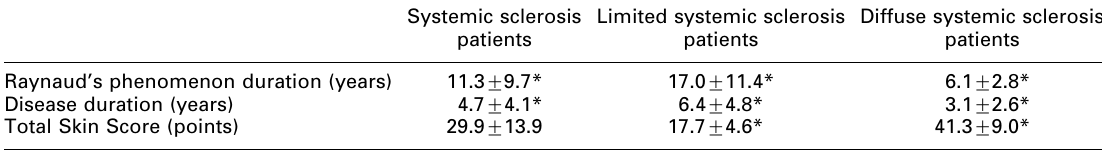
Table 1. Characteristics of the examined